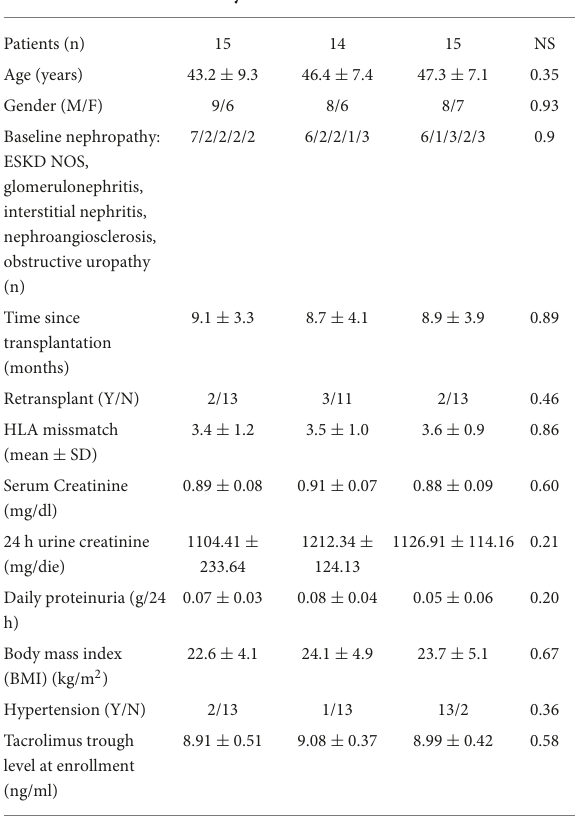
BK viruria BK viremia Controls P only and viruria